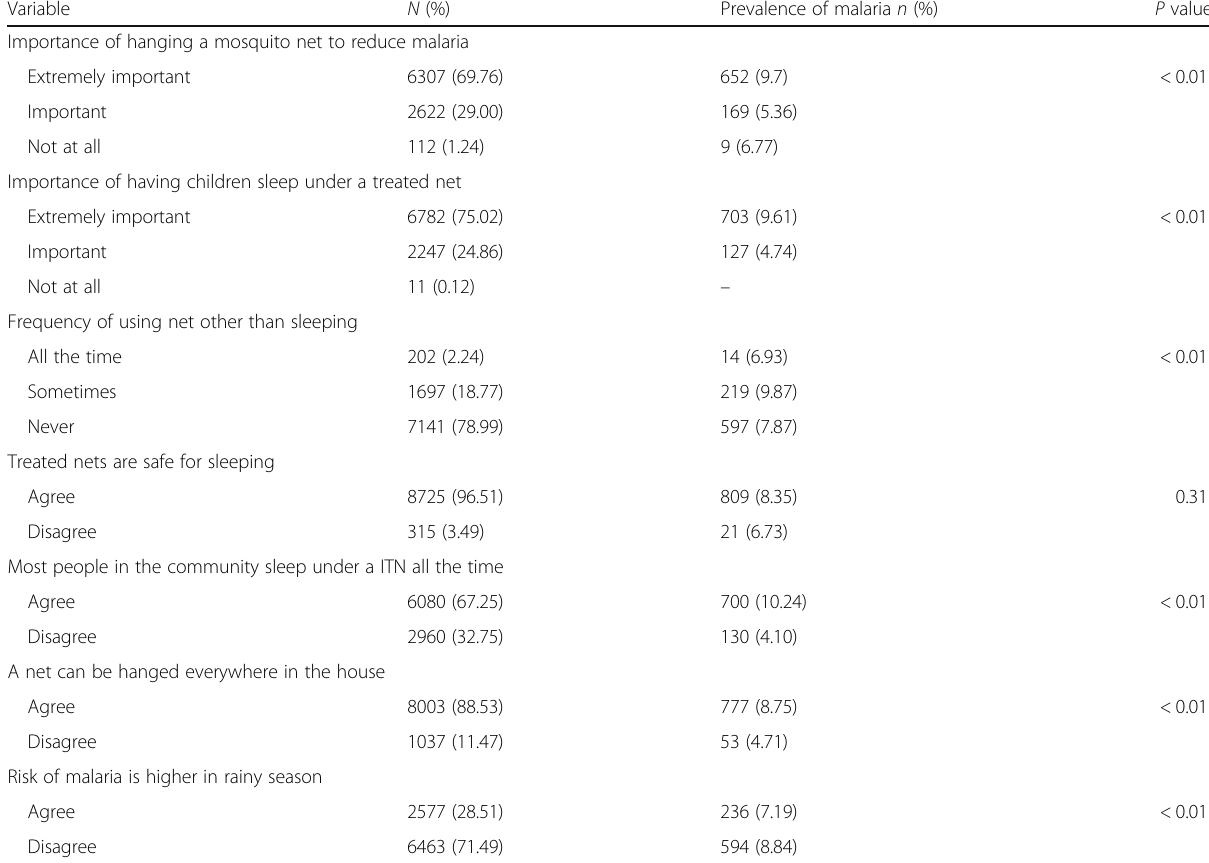
Table 2 Chi-square test of association on respondent ’ s knowledge, attitude on malaria and mosquito net ( N = 9040) Variable N (%) Prevalence of malaria n (%) P